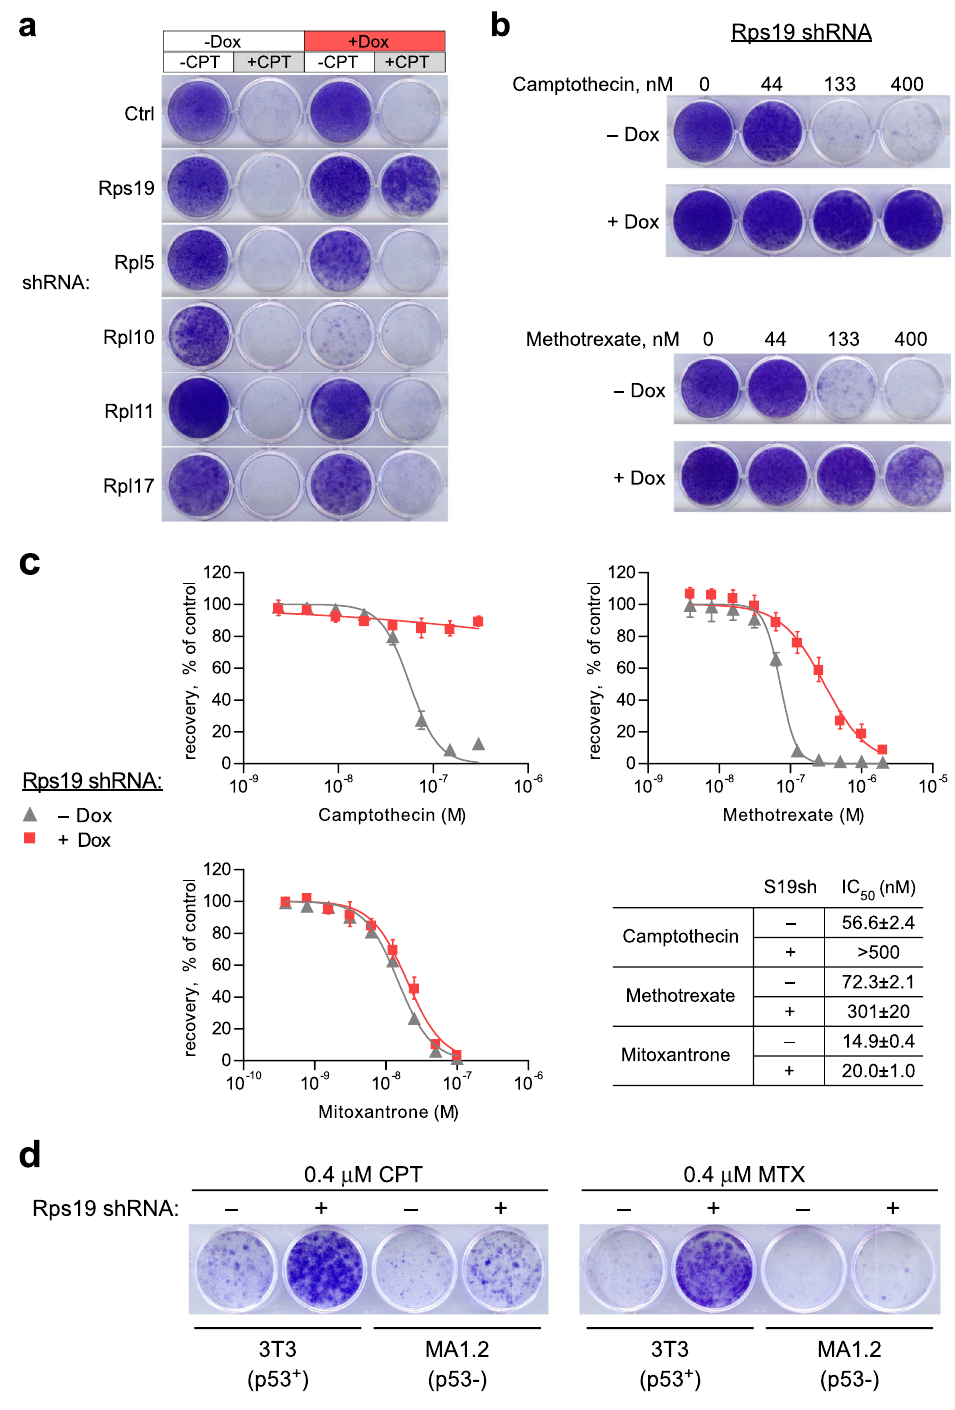
Figure 4. Transient depletion of r-proteins via Dox-inducible shRNA identifies Rps19 as an inducer of cytoprotection against CPT and MTX. ( a ) The indicated shRNAs were either induced with Dox for 48 h or not induced, cells were treated with 0 or 0.4 μ M CPT for 24 h and the surviving viable cells were stained with crystal violet after a 5-day recovery in Dox-free medium. ( b ) Rps19 shRNA was induced for 48 h with Dox or not induced, cells were treated with the indicated concentrations of CPT for 24 h or MTX for 48 h and stained as above. ( c ) Dox induction of Rps19 shRNA confers protection against CPT and MTX, but not mitoxantrone. Cells were induced for 48 h with Dox or not induced and then treated with various concentrations of CPT and mitoxantrone for 24 h or with MTX for 48 h. Results were analyzed as in Fig. 2. ( d ) p53 is necessary for cytoprotective effects of Rps19 depletion. 3T3 cells and its p53-null derivative line MA1.2 were transfected with Dox-inducible Rps19 shRNA and analyzed as in Fig.